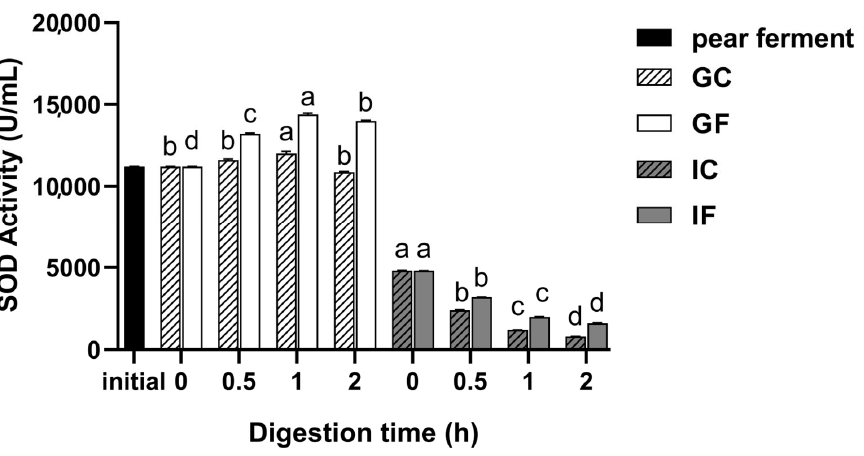
Figure 4. Changes of SOD activity of ‘Xuehua’ pear ferment during the simulated gastric and intestinal digestion in vitro. Different letters indicate significant differences in the same group under different digestion times ( p < 0.05). Data shown as means ± SD of three replicates ( n = 3).